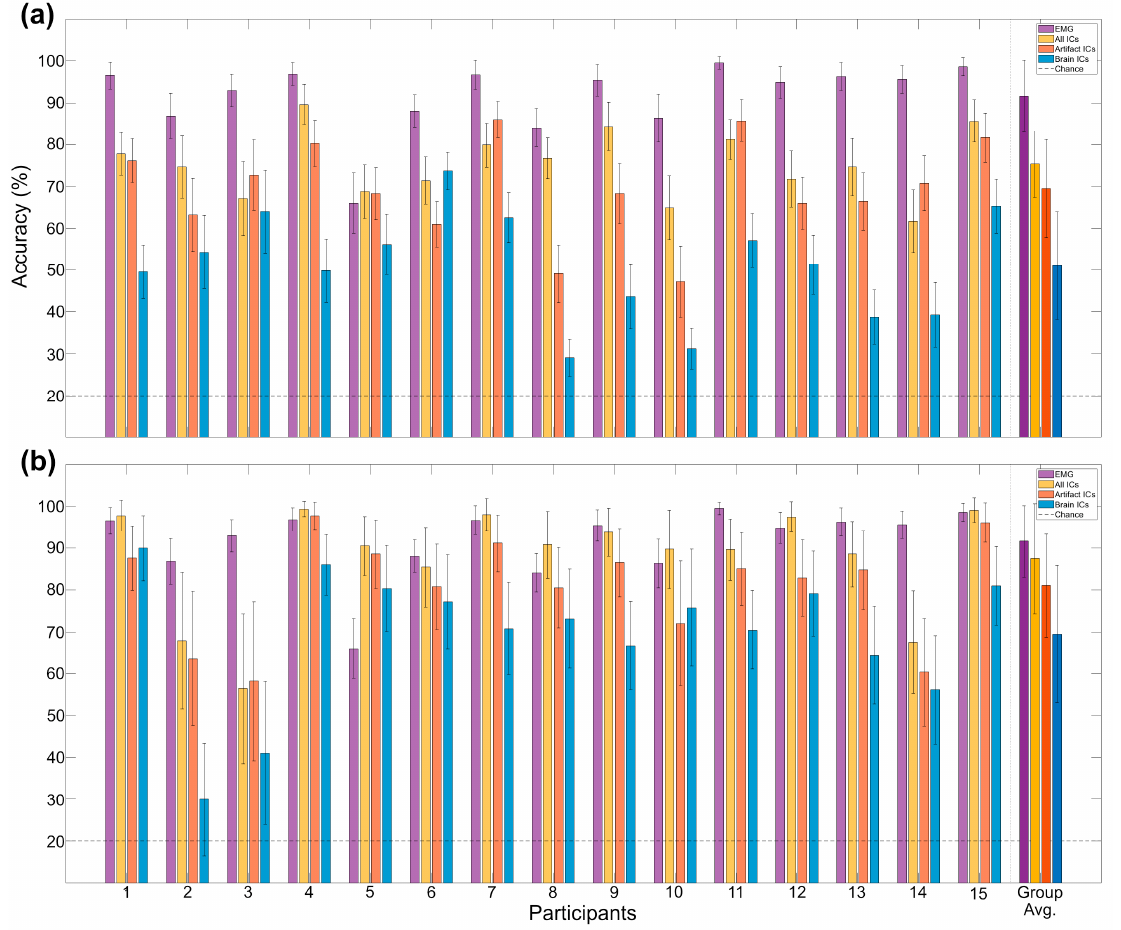
Figure A3. Participant-level classification accuracy. Displayed from time-frequency analysis ( a ) and bandpower analysis ( b )—also compared with EMG. Multi-class classification between 5 equally likely movements, chance level indicated with dotted